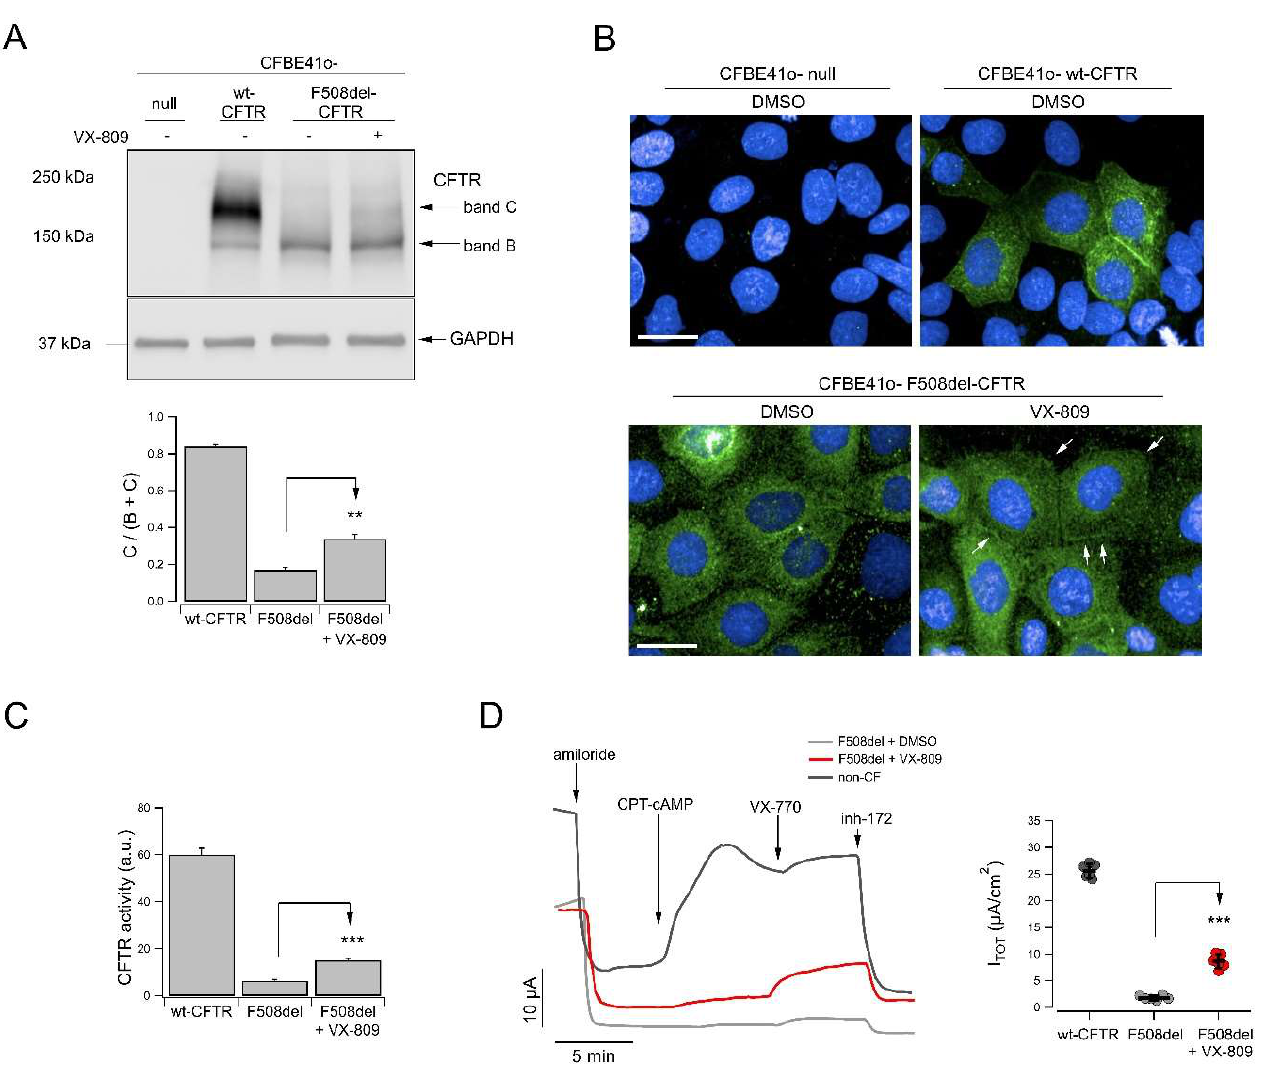
Figure 3. Evaluation of VX-809 corrector activity in human bronchial epithelial cells. ( A ) Biochemical analysis of CFTR expression pattern in total lysates from wild-type or F508del-CFTR expressing CFBE41o- cells after 24 h treatment (for mutant CFTR only) with vehicle alone (DMSO) or VX-809 (3 µ M) prior to lysis. For comparison, whole lysates derived from CFBE41o- cells not expressing CFTR (null cells) are also shown as controls for antibody specificity. Arrows indicate mature, complex-glycosylated (band C) and immature, core-glycosylated (band B) forms of CFTR protein. The bar graph shows quantification of CFTR bands. Data are expressed as C band/B band ratio normalized for the value observed in cells treated with DMSO. Data are expressed as means ± SEM, n = 3 independent experiments. Statistical significance of VX-809 treatment was tested by Student’s t -test. Symbols indicate statistical significance versus DMSO: **, p < 0.01. ( B ) Representative